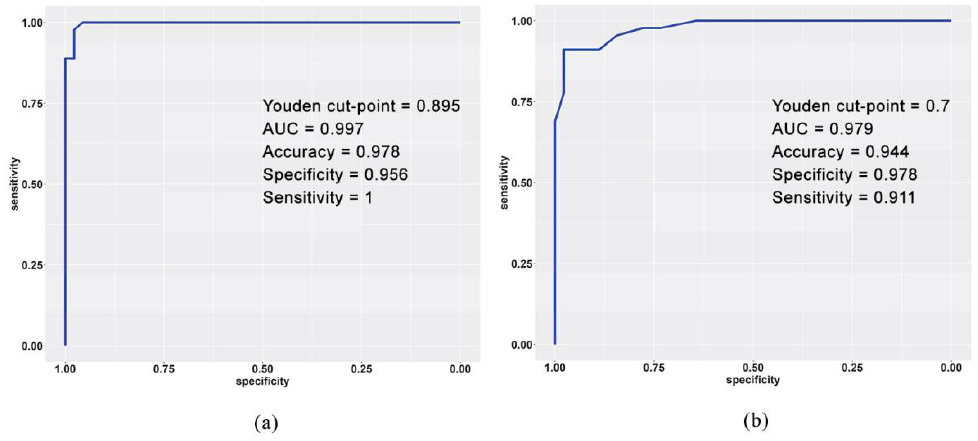
Figure 5. Assessment of LTL as a biomarker of HD. ROC curves show the performance to discriminate diagnostic groups based on LTL value: ( a ) pre-HD (T0) vs. controls; ( b ) pre-HD (T0) vs. manifest HD (T1). The AUC, best sensitivity, best specificity, and optimal cut-point based on Youden criterion are